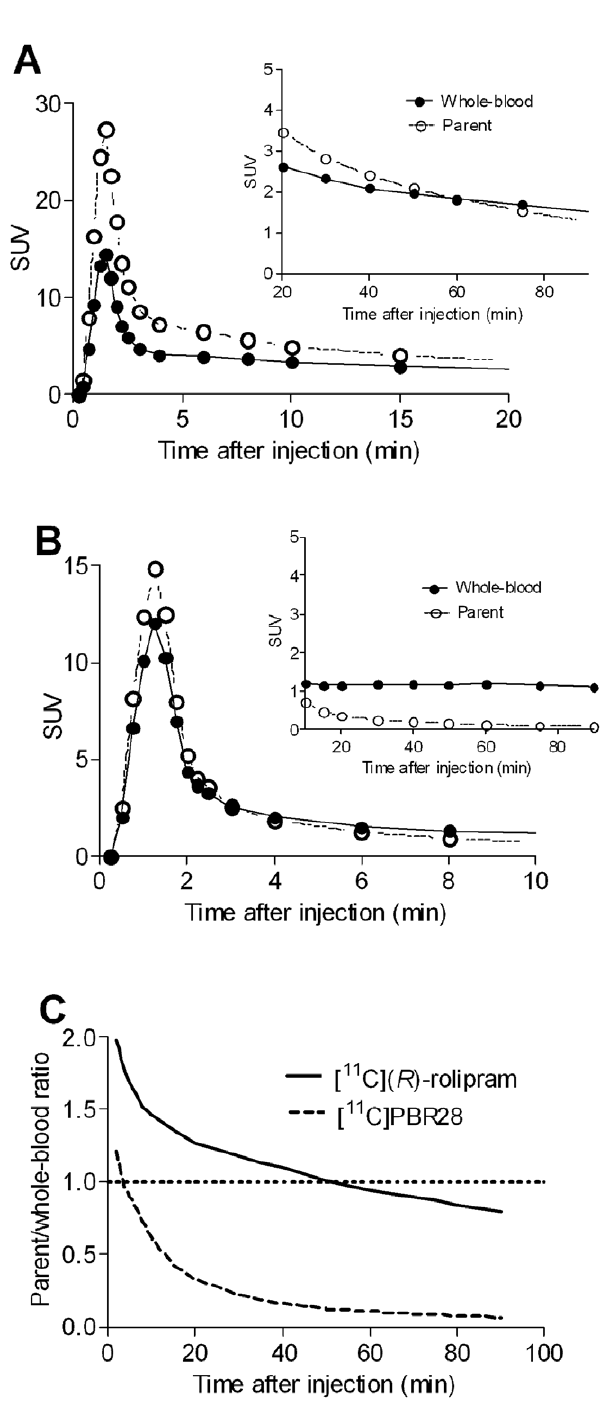
Figure 2. The average concentrations of radioactivity in whole blood (solid line) and parent radioligand in plasma (dashed line) over time for [ 11 C]( R )-rolipram (n=12) (A) and [ 11 C]PBR28 (n=19) (B). The main figures show the first 20 minutes of the curves and the inserts the remaining part. Although the shape of the whole blood curves was similar for the two tracers, the relative concentration of parent and metabolites differed. The mean ratio of concentration of parent radioligand in plasma to total radioactivity in whole blood ( C ) showed that [ 11 C]( R )-rolipram remained the predominant component of whole blood radioactivity throughout the scan. In contrast, radio- metabolites of [ 11 C]PBR28 became the predominant component of whole blood radioactivity after the first few